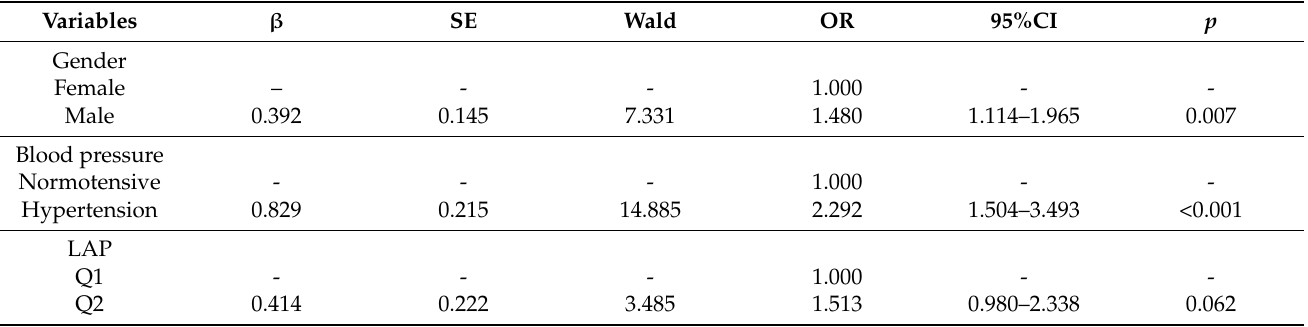
Table 3. Logistic regression model for risk factors associated with